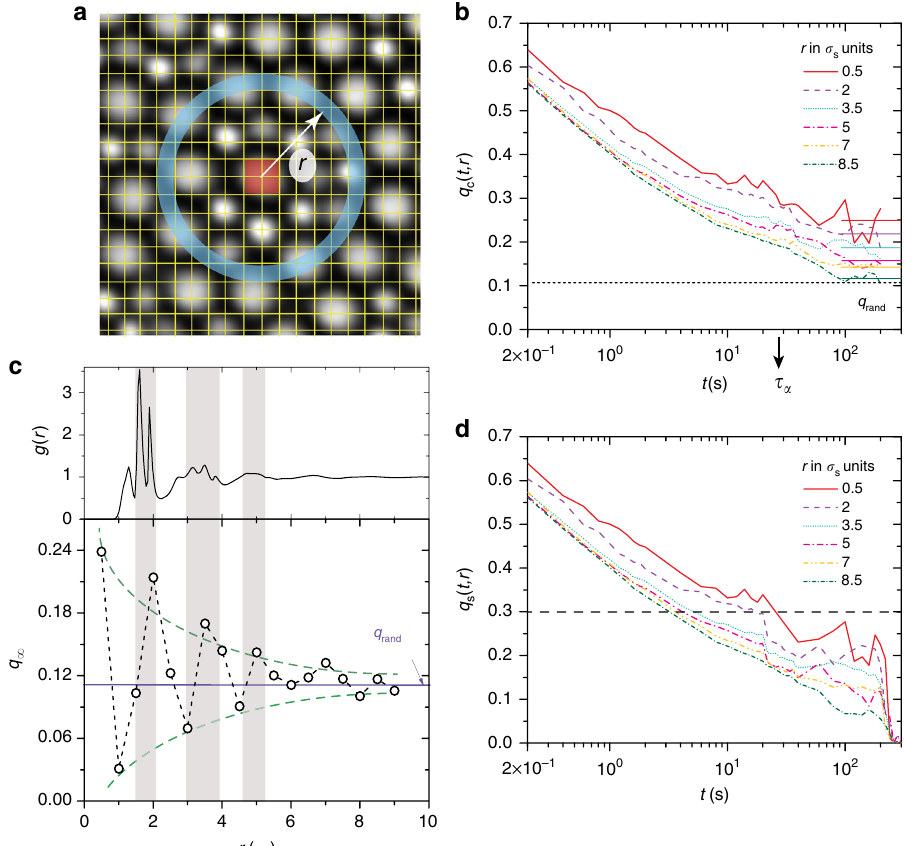
Fig. 1 Con fi gurational and self-overlap around self-induced pins. a The background image represents a small portion of the fi eld of view of a colloidal supercooled liquid. The grid corresponds to a box size of 0.5 σ s . The red box in the center of the image represents a self-induced pin with q c ( τ α ) > 0.9 over a 1 σ s box size. Upon fi ne-graining to 0.5 σ s boxes to improve the spatial resolution, the overlap of the self-induced pin is shared by four boxes within the red region. 〈 q c ( t ) 〉 r is obtained by radially averaging boxes at a distance r (blue ring) from the center. b Time evolution of con fi gurational overlap q c ( t , r ) for ϕ = 0.74 at different r 's from the self-induced pin. The horizontal lines represents q ∞ ( r ). The horizontal red dashed line represents the random occupancy in the bulk q rand . c Top panel shows g ( r ) for the binary supercooled liquid at ϕ = 0.74 and the bottom panel shows the evolution of q ∞ around a self-induced pin. The purple line corresponds to the bulk value q rand . The green lines are only a guide to the eye. For the sake of clarity, b shows q c ( t , r ) only for r 's where q ∞ > q rand . d Time evolution of self-overlap q s ( t , r ) for ϕ = 0.74 at different distances ( σ s ) from the self-induced pin. The horizontal red dashed line corresponds to q s ( t , r ) =